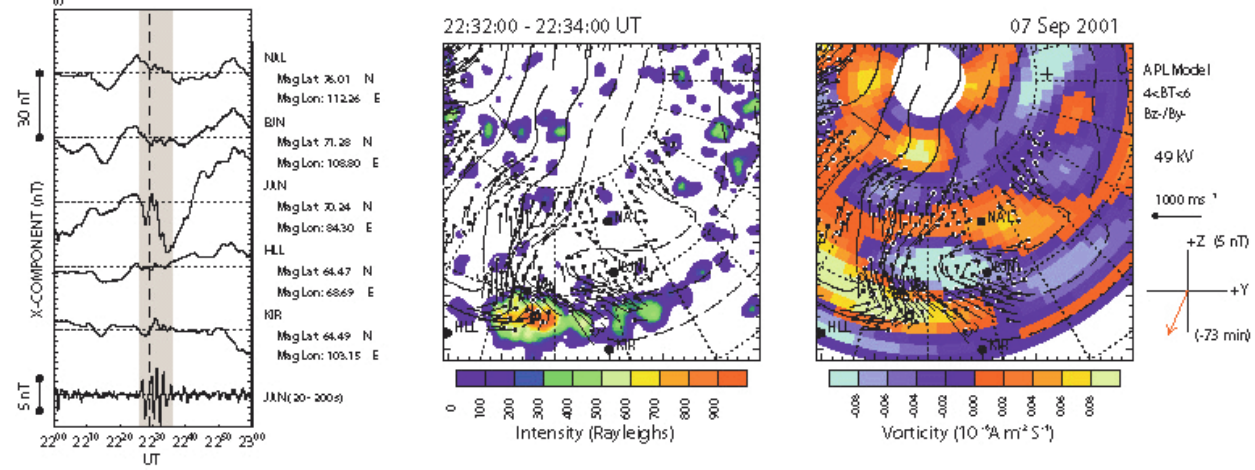
Fig. 19. (a) X- component magnetometer data and Pi2-filtered (20-200s) data. The vertical dashed line at 22:29 UT indicates the time of a BBF event observed by Cluster and the grey-shaded portion represents the interval 22:26–22:36 UT. (b) IMAGE UV auroral data and (c) patterns of field-aligned currents derived from the vorticities of the ionospheric flows for the interval 22:32-22:34 UT. Positive vorticities (red/yellow) indicate an upward field-aligned current, and negative vorticities (blue) a downward field-aligned current. Also shown are flow vectors and equipotential contours derived using the Map Potential model, the locations of the five magnetometers used, and the Cluster footprint location, indicated by the hollow black circle. At the right side of the figure the transpolar voltage, Applied Physics Laboratory (APL) statistical model, vector scale and IMF vector are shown. (From Grocott et al., 2004.)